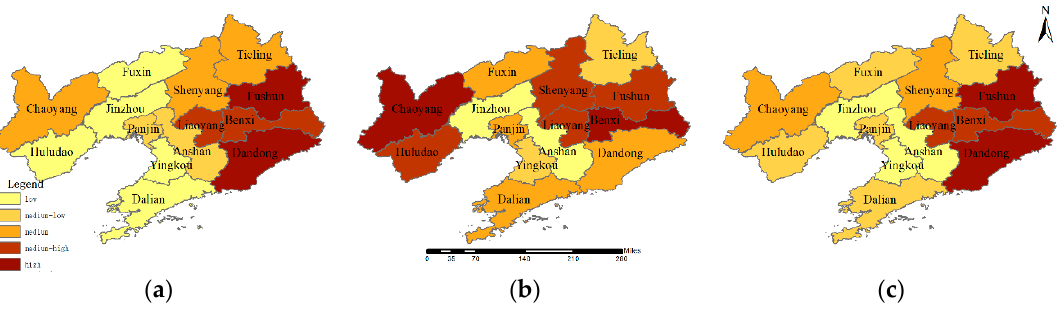
Figure 5. The spatial distribution of crop water use efficiency in Liaoning Province. ( a ) Crop growth water use efficiency. ( b ) Crop ecological water use efficiency. ( c ) Crop production water use efficiency.